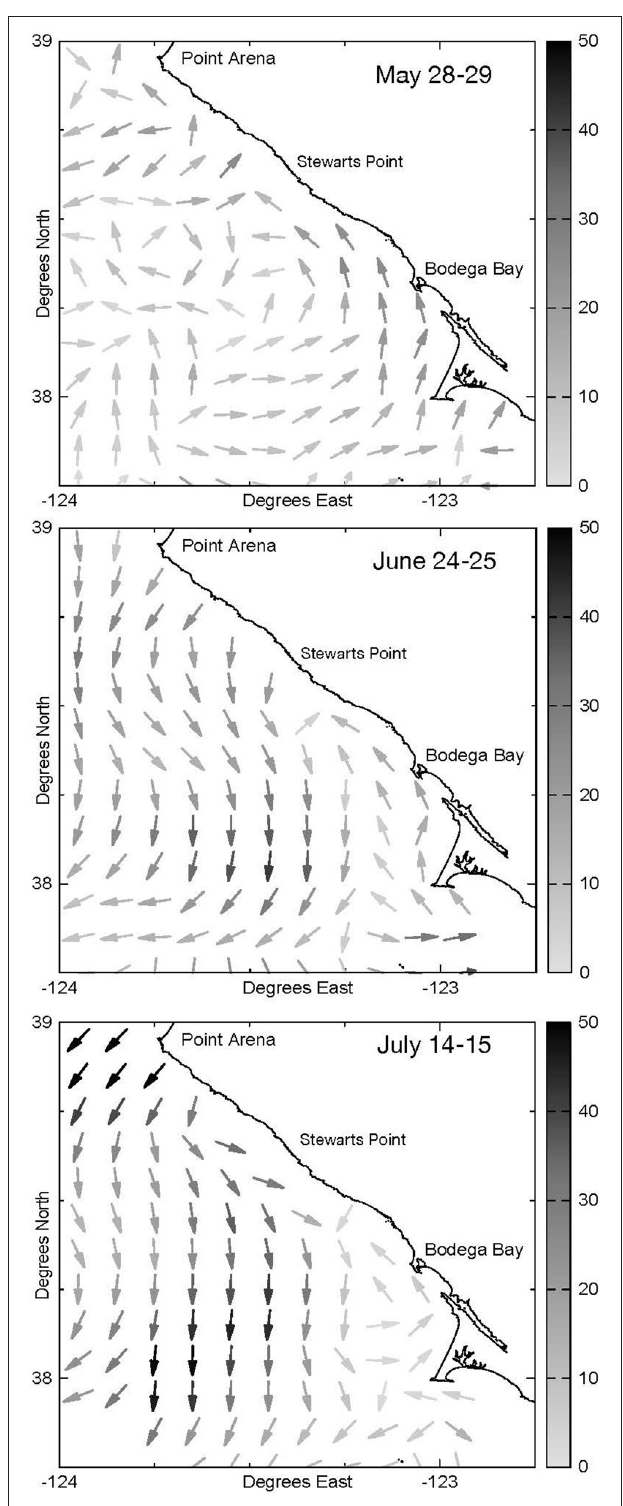
FIGURE 3 | Two-day mean surface current velocity recorded by high-frequency radar across the study region during cruises conducted on 28–29 May, 24–25 June, and 14–15 July 2009. Arrow orientation shows direction while darkness of shading represents speed